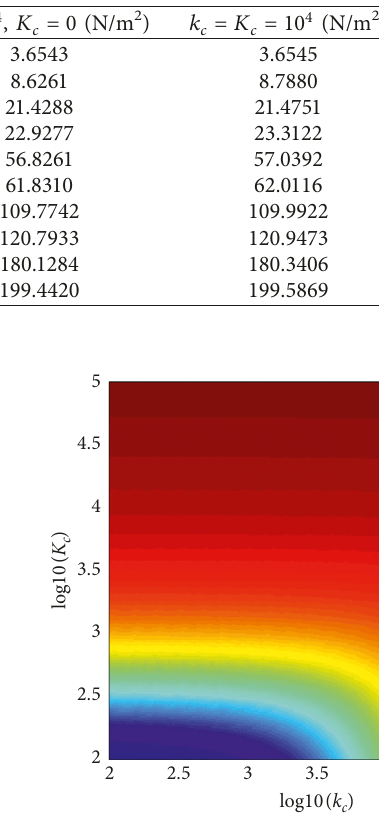
for the three-stepped beams. Ω